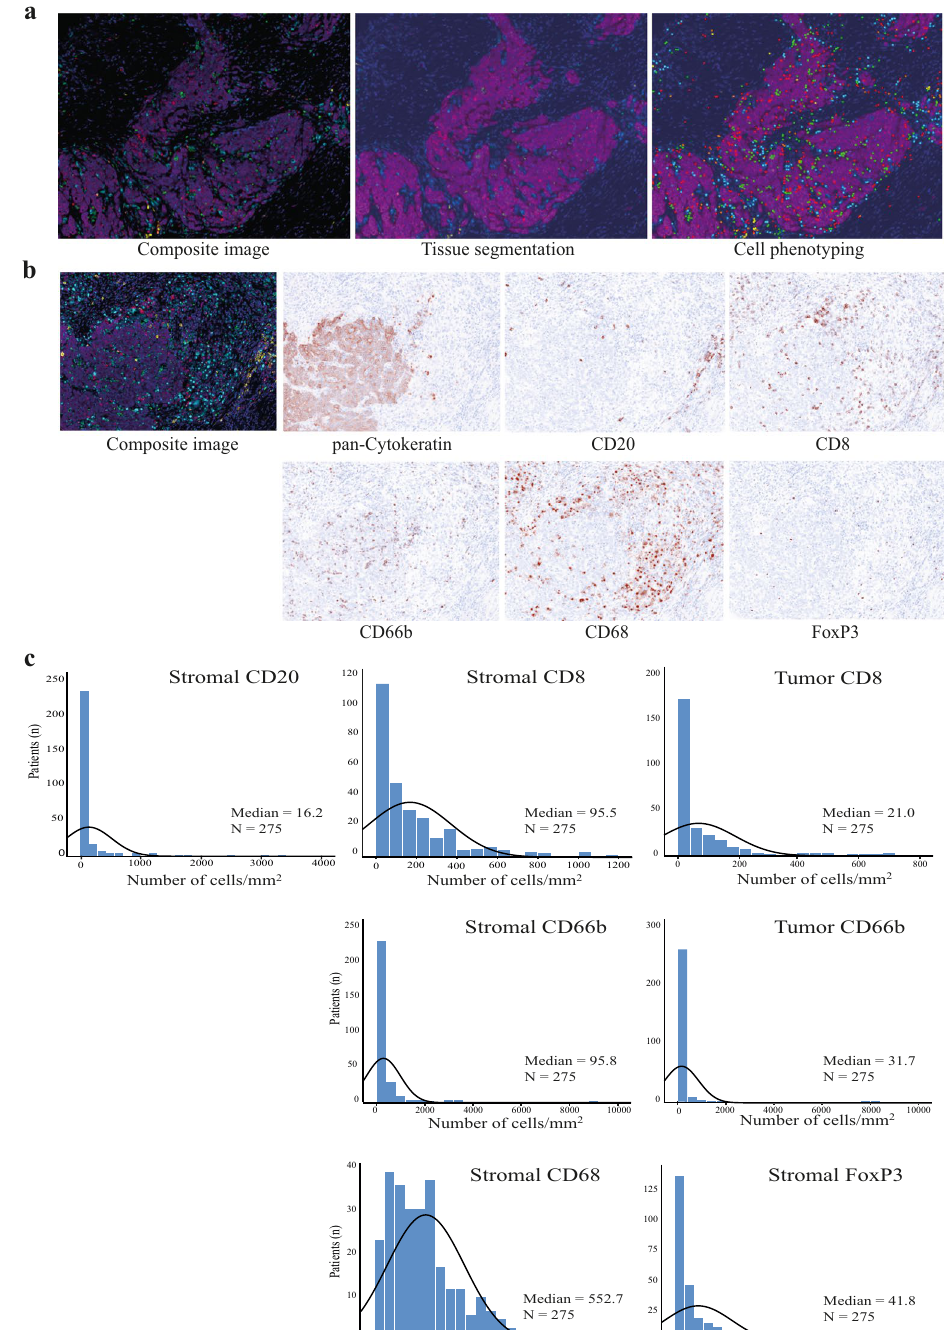
Figure 1. Multispectral imaging of immune cell infiltrates in CRC tissues. ( a ) A high-magnification area (20x) of a representative multiplexed IHC stained composite image after imaging and spectral unmixing (left panel), after tissue segmentation into tumour (magenta) and stromal (blue) compartments (middle panel), and after cell phenotyping (right panel). The following colors were used to identify the different markers; pan- Cytokeratin (magenta), CD20 (yellow), CD8 (red), CD66b (green), CD68 (cyan), FoxP3 (orange), and DAPI (blue). ( b ) Illustrates the staining pattern of the individual markers on a high-resolution area of a representative TMA core, after spectral unmixing, using the pathology view tool. ( c ) Histograms displaying the distribution (number of cells per mm 2 ) of infiltrating immune cell subsets in the cohort of 275 CRC patients. In addition, the normal curve and the median number of infiltrating cells is